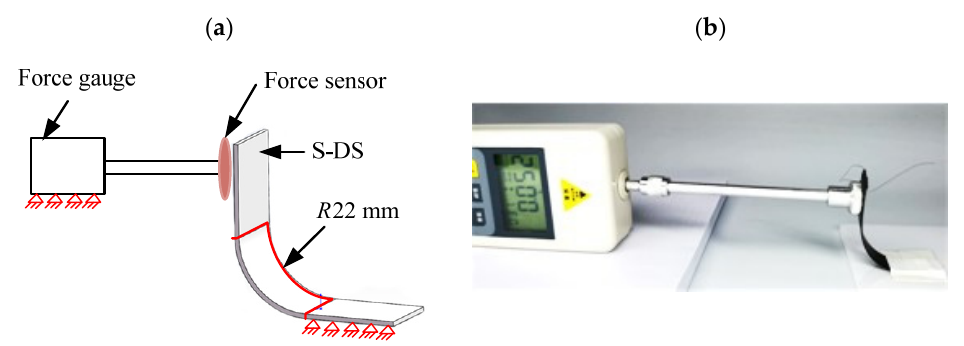
Figure 20. Recovery force measurements for S-DS: ( a ) schematic diagram of the recovery force measurement of S-DS; ( b ) experimental diagram of the recovery force measurement of S-DS. Table 5. Measurement data for the recovery forces.